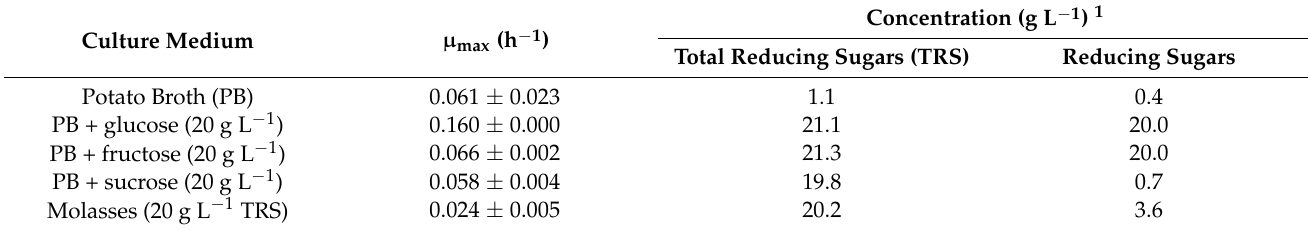
Table 1. Maximum specific growth rate ( µ max ) of C. vulgaris grown in potato broth with different carbon sources and in molasses, at 30 ◦ C, under constant shaking, and the concentration of reducing sugars in each medium.